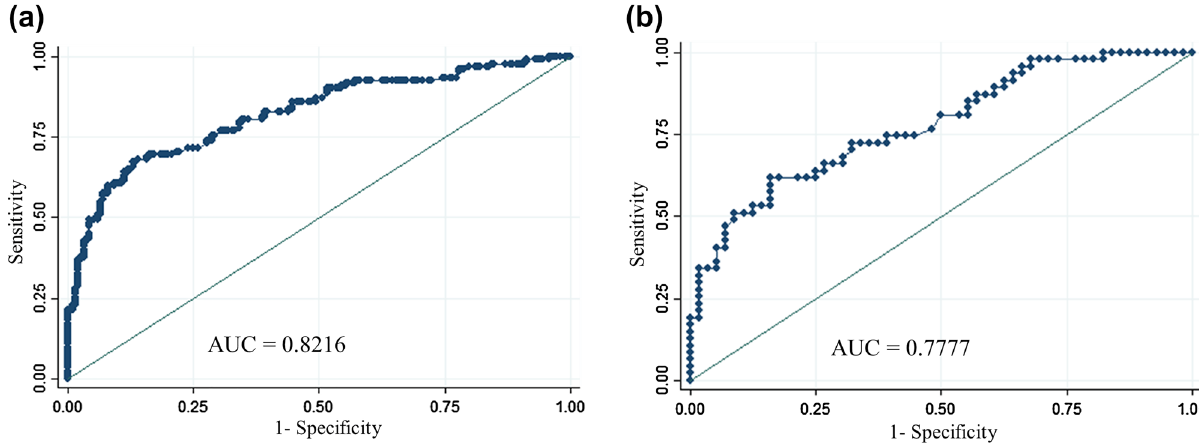
Figure 2. Receiver operating characteristic curve of nomogram. ( a ) Training group of 312 patients. ( b ) Validation group of 97 patients.